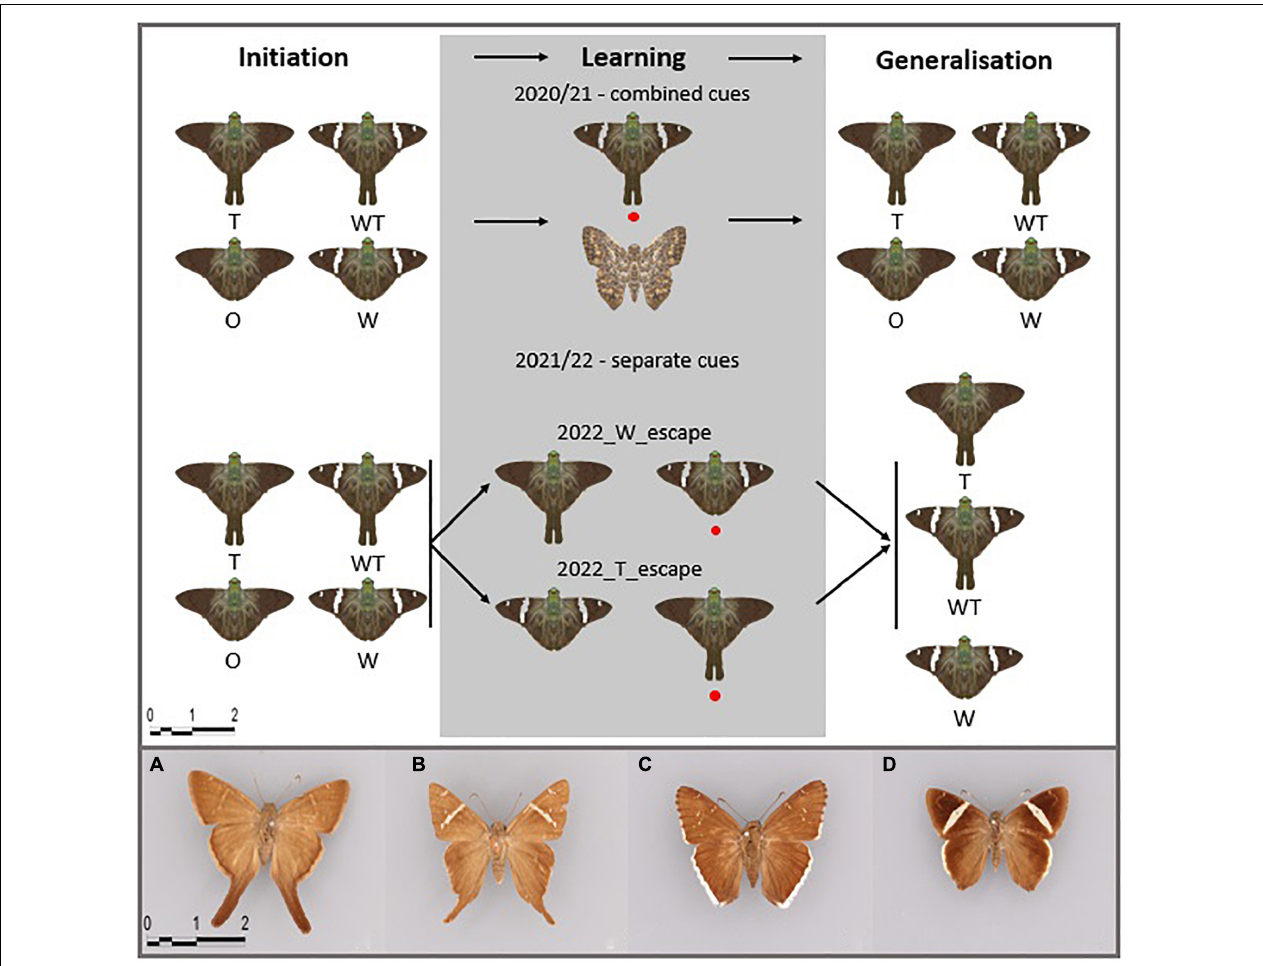
FIGURE 1 | Experimental setup for the three behavioral tests of learning and generalization abilities of pre-trained blue tits and depiction of used butterfly phenotypes: T, hindwing tails; W, white bands; WT, white bands and hindwing tails; O, neither hindwing tails nor white bands. The red circle marks the evasive model during the Learning phase. Initiation was introduced during the winter of Year 1 resulting in a lower sample size. The phenotypes resemble Neotropical butterflies: (A) Spicauda simplicius (Stoll, 1790), (B) Cecropterus carmelita (Herrich-Schäffer, 1868), (C) C. casica (Herrich-Schäffer, 1868), and (D) C. zarex (Hübner, 1818) (captured in the Natural History Museum